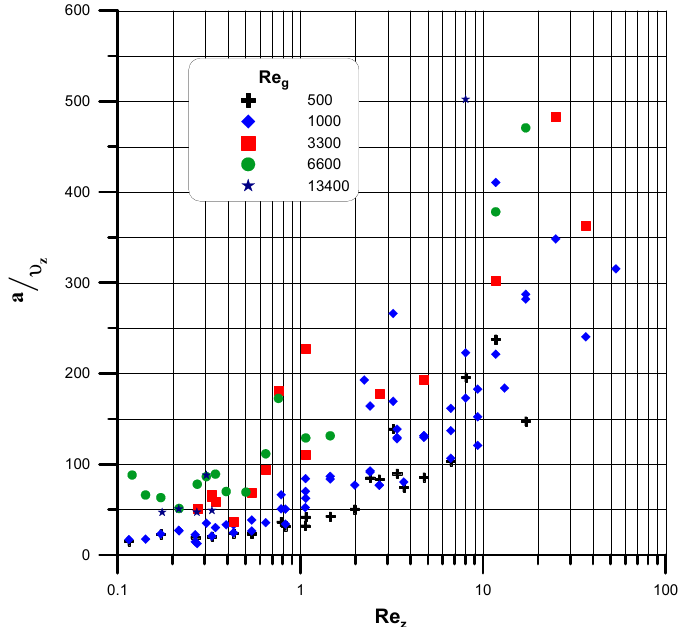
Figure 9. Results of experiments and calculations of dependencies between the mean reduced value of the wave amplitude a/ ϑ z = f(Re z , Re g ) accompanying annular gas-very viscous liquid flow. Analysis of the effect of the ratio of gas and liquid velocities to the quantities characterizing the characteristics of the liquid film waves demonstrated that this parameter significantly affects the value of the velocity of wave displacement on the liquid film surface, as well as the frequencies and amplitudes of the waves. However, the results did not indicate the influence of this relation on the wavelength.